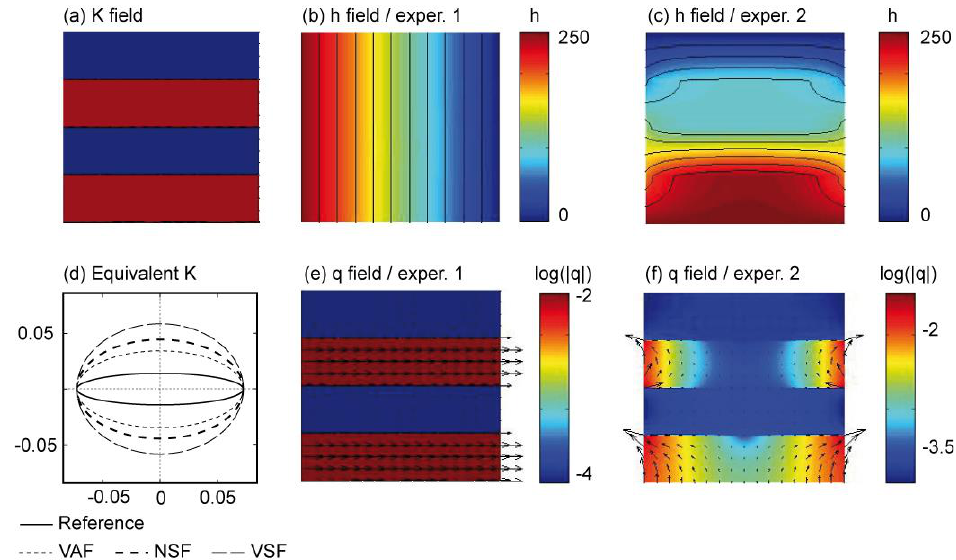
Figure 16. Medium K2 with linearly varying head boundary conditions (GRD): ( a ) K field, the red layers are the high permeability layers. ( b,c ) Head distribution in the domain for the two flow experiments. ( d ) Ellipsoids of the square root of flux directional permeability obtained with the VAF, NSF, and VSF criteria. ( e , f ) Darcy velocity fields for the two flow experiments; the background color represents the norm of the Darcy velocity.